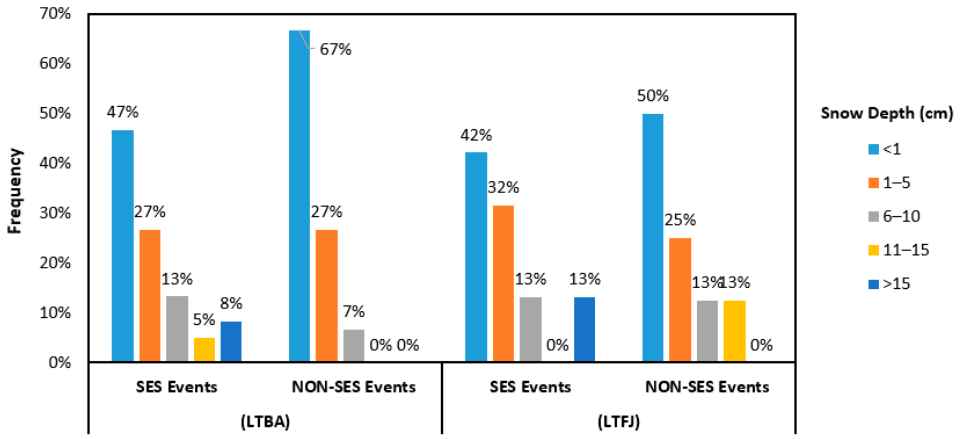
Figure 7. Distribution of snow depths in SES and non-SES events at LTBA and LTFJ. In SES and non-SES events, changes in snow depths depending on meteorological parameters were analysed for both airports (Tables 5 and 6). For each snow depth range in Figure 7, SES and non-SES events were handled separately. In this process, the average meteorological parameter values at the airport, SS and upper atmospheric levels were determined. At both airports, snow depths often increased in both SES and non-SES events as air temperatures decreased. The average dew point depression (T-Td) was mostly higher in SES events than in non-SES events. Moreover, as dew point depression decreased in both SES and non-SES events, snow depth mostly increased for both airports. The average wind speed values were higher in non-SES events compared to SES events, and as the snow depth increased, wind intensity was generally higher in both events. In all SES events, northerly wind directions were dominant; on the other hand, in non-SES events, although similarly northerly directions were dominant, variable wind directions were also